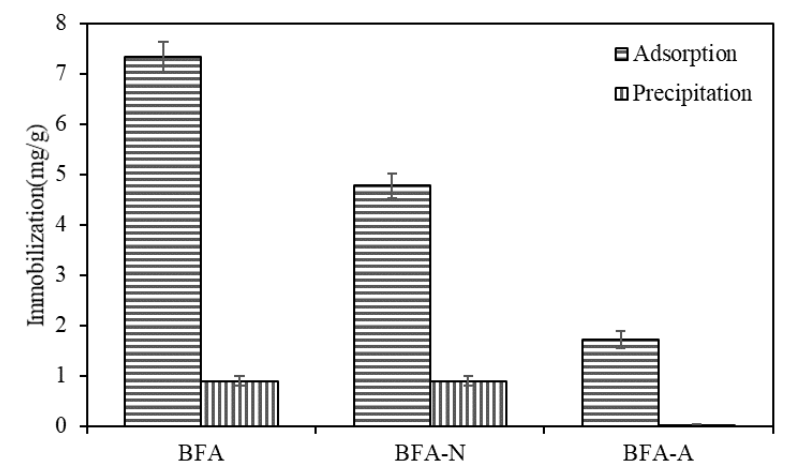
Figure 10. The precipitation in Cd